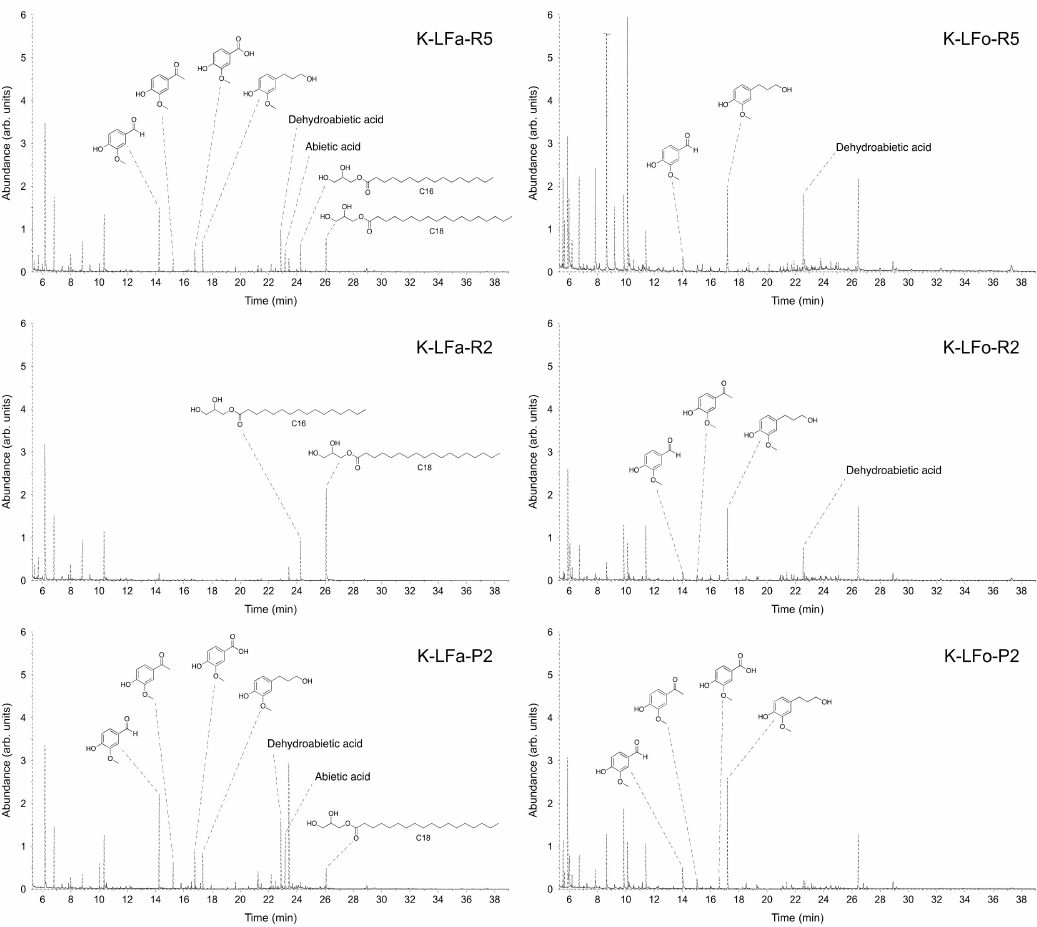
Figure 7. GC / MS total ion chromatograms of delivered fractions from aqueous and organic processes using K-LFa / o-0. Selected component identification by MS library matching is reported for each